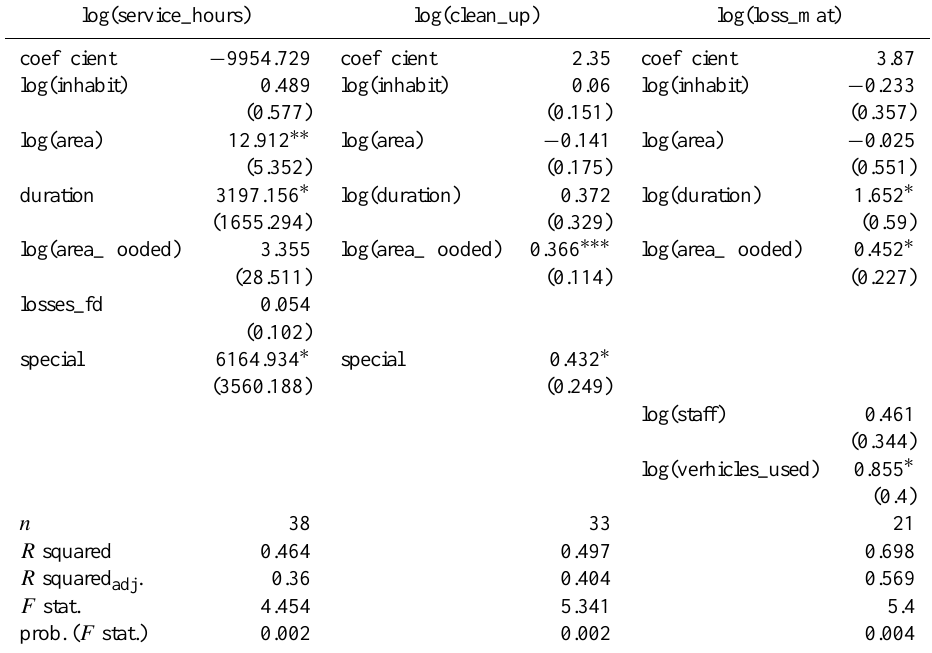
Table 6. Model and results